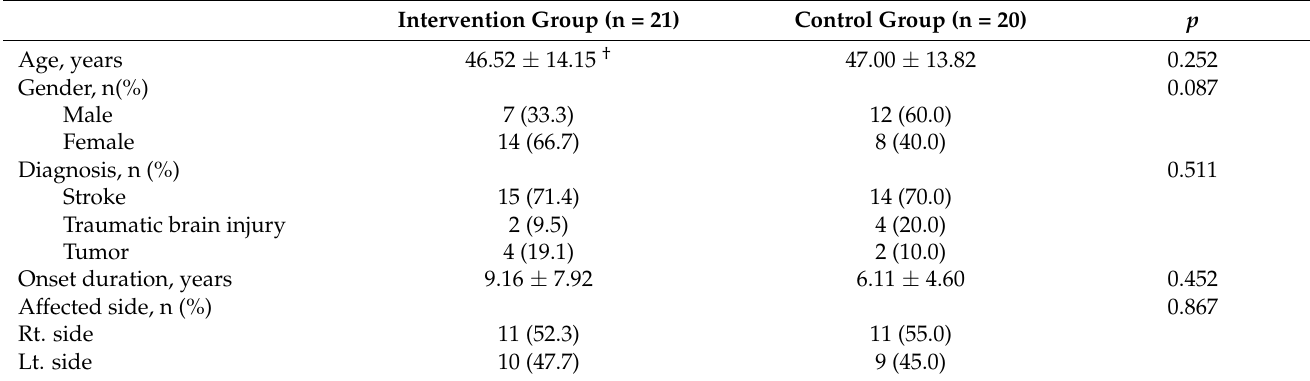
Table 1. Clinical characteristics of subjects (N =